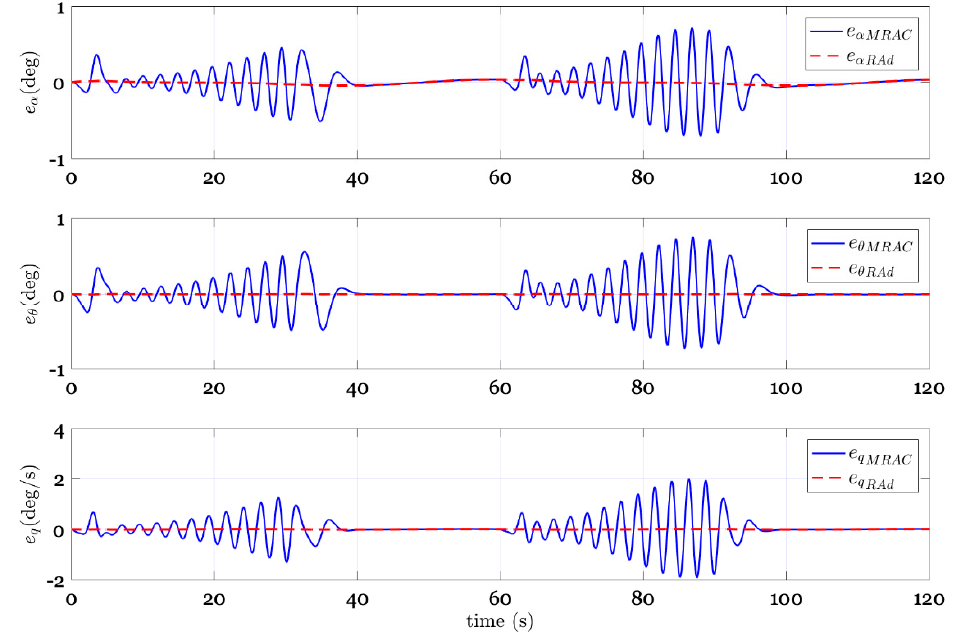
Figure 3. Status errors from MRAC and robust adaptive controller with ρ λ = ρ θ = 0.01.